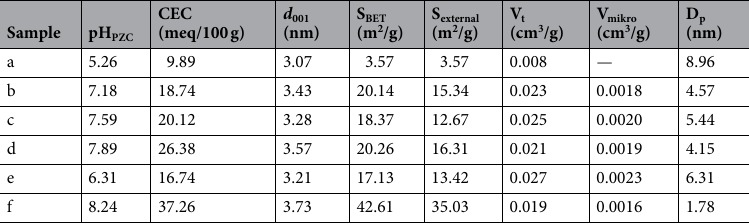
Table 2. pH PZC , CEC, d 001 , surface and pore parameters of (a) RMF, (b) MMF-H2.5, (c) MMF-OH3.0, (d) MMF-La5.0, (e) CMMF-400 and (f)